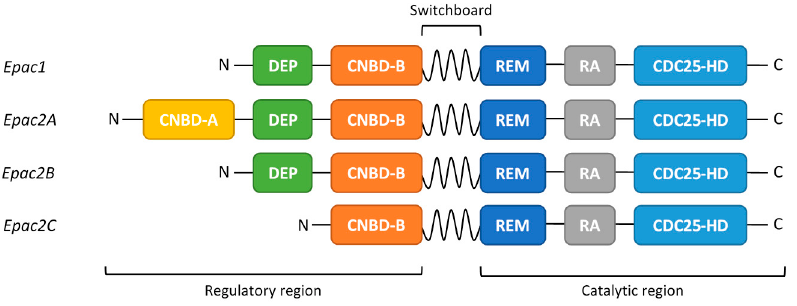
Figure 1. Primary structure of the different exchange proteins activated by cyclic AMP (EPAC) isoforms. The N-terminal regulatory region is directly connected to the C-terminal catalytic region through the switchboard region. Cyclic AMP interacts with the cyclic nucleotide-binding domain (CNBD-B), present in all EPAC isoforms, to trigger enzyme activation. Epac2A has an extra, non-functional cyclic AMP binding domain (CNBD-A). The other functional EPAC domains are indicated; DEP—Dishevelled, Egl-10, Pleckstrin domain, required for protein-protein and protein-lipid interactions; REM—Ras exchange motif, required for the stability of the CDC25-HD catalytic domain; RA—Ras association domain; allows interaction with members of the Ras-superfamily of small GTPases; CDC25-HD—CDC25 homology domain, which contains catalytic GEF activity to Rap 1/2 [14,36,37].